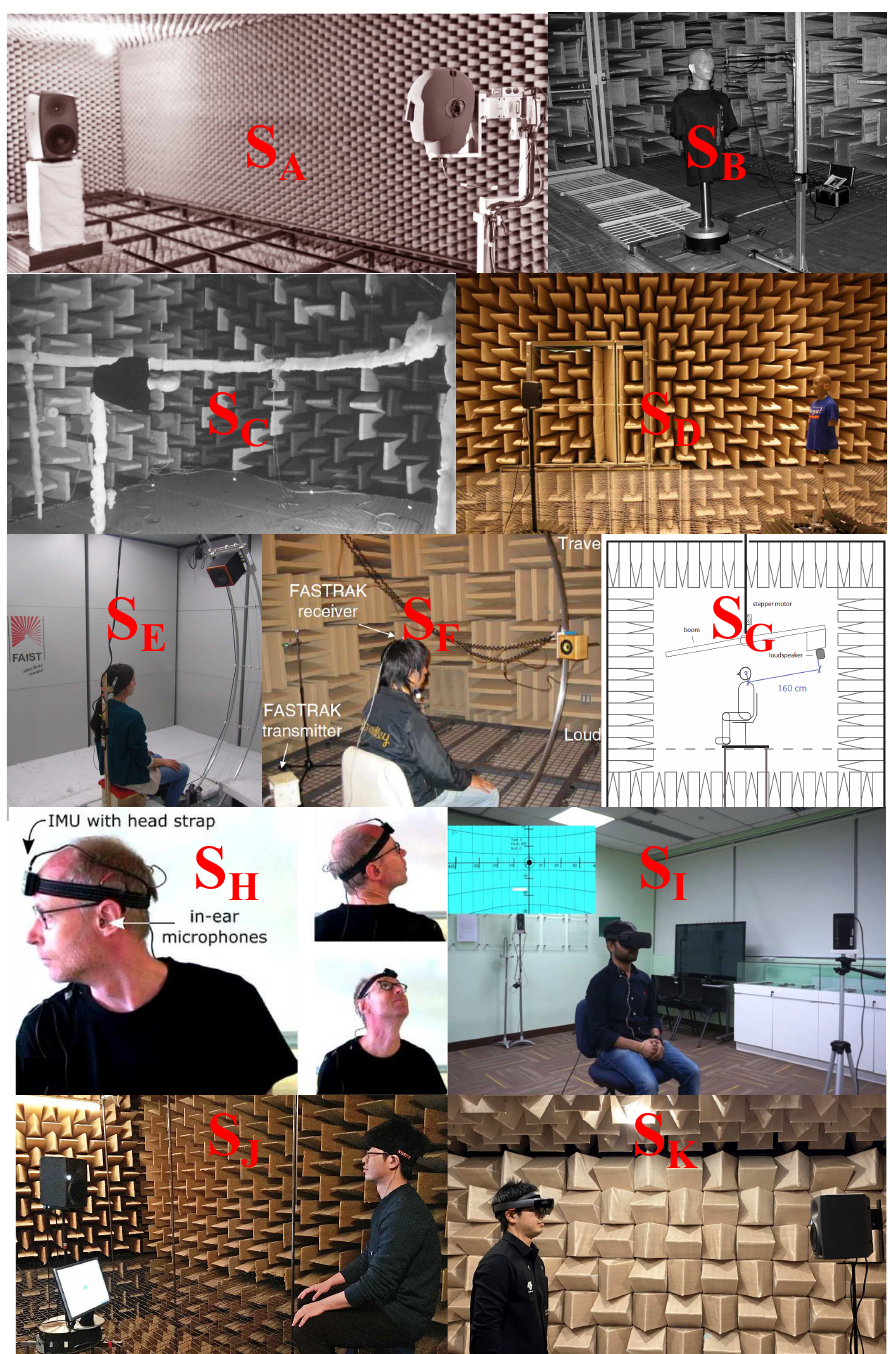
Figure 9. Examples of single-loudspeaker-based HRTF measurement setups taken from [15,78,114,120,136–142] (All pictures are taken from available publications, some of them are partly cropped to fit into the overall picture). Setups S H –S K show novel measurement modes particularly designed for the fast HRTF measurement of human subjects. A loudspeaker is placed at a fixed position and continuously emits the excitation signal, while the subject is asked to rotate her/his head to cover different measurement directions. The head rotation is recorded using a head tracker device during the measurement. In addition, the movement pattern and desired measurement points are displayed on a video monitor (see the setup S J ) or a head-mounted display (HMD, see setups S I and S K ) to prompt the subject to cover unvisited measurement positions. The excitation signal, recorded ear signals and the